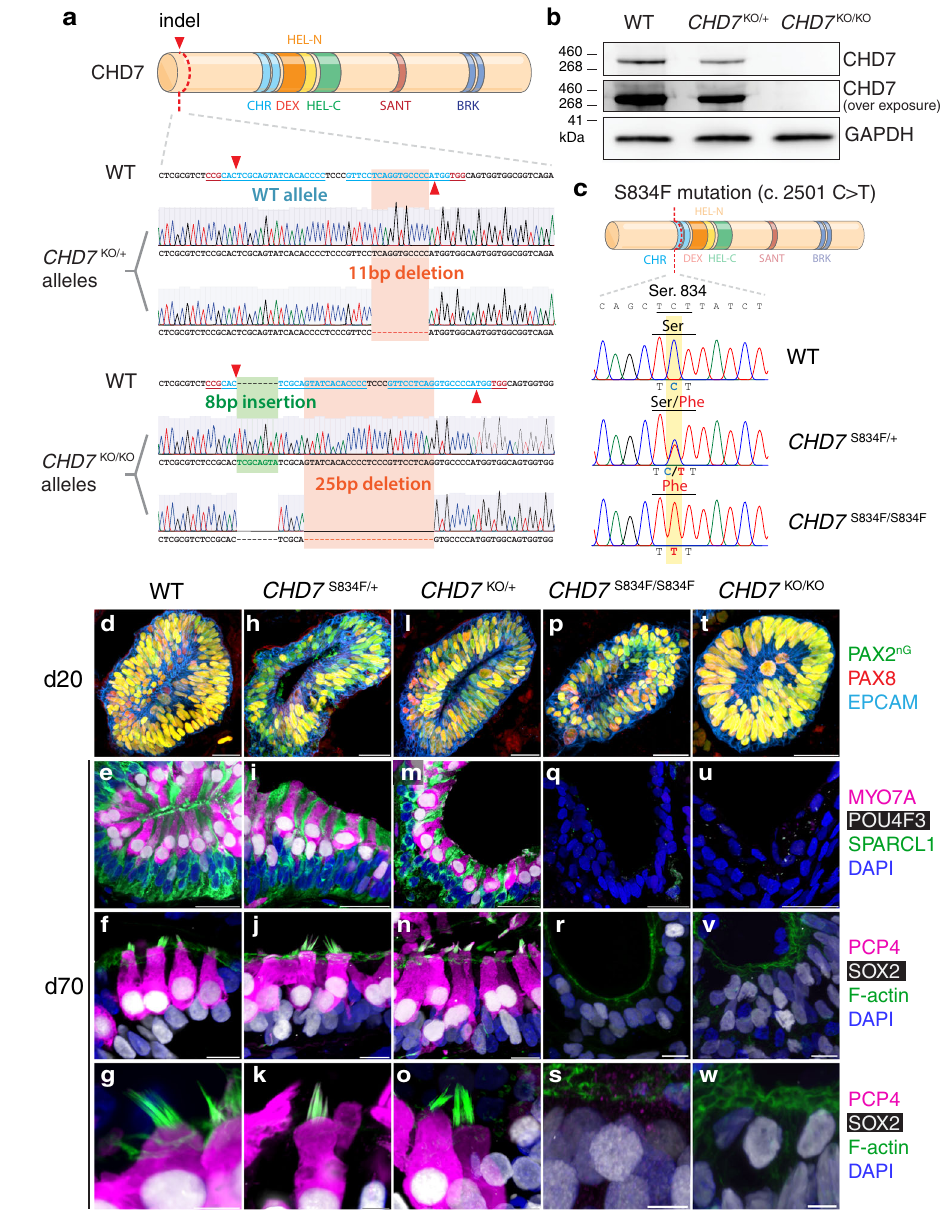
Fig. 2 | CHD7 and its ATP-dependent chromatin remodeling activities are required for sensory epithelium derivation. a Sanger sequencing chromato- grams of CHD7 KO/+ and CHD7 KO/KO alleles cloned into TOPO vectors. b Western blotting of WT ( PAX2 nG ), CHD7 KO/+ , and CHD7 KO/KO hESCs using an anti-CHD7 anti- body. Source data are provided as a Source Data fi le. c Sanger sequencing chro- matogramsofWT( PAX2 nG ), CHD7 S834F/+ ,and CHD7 S834F/S834F hESCsatthe CHD7 c.2501